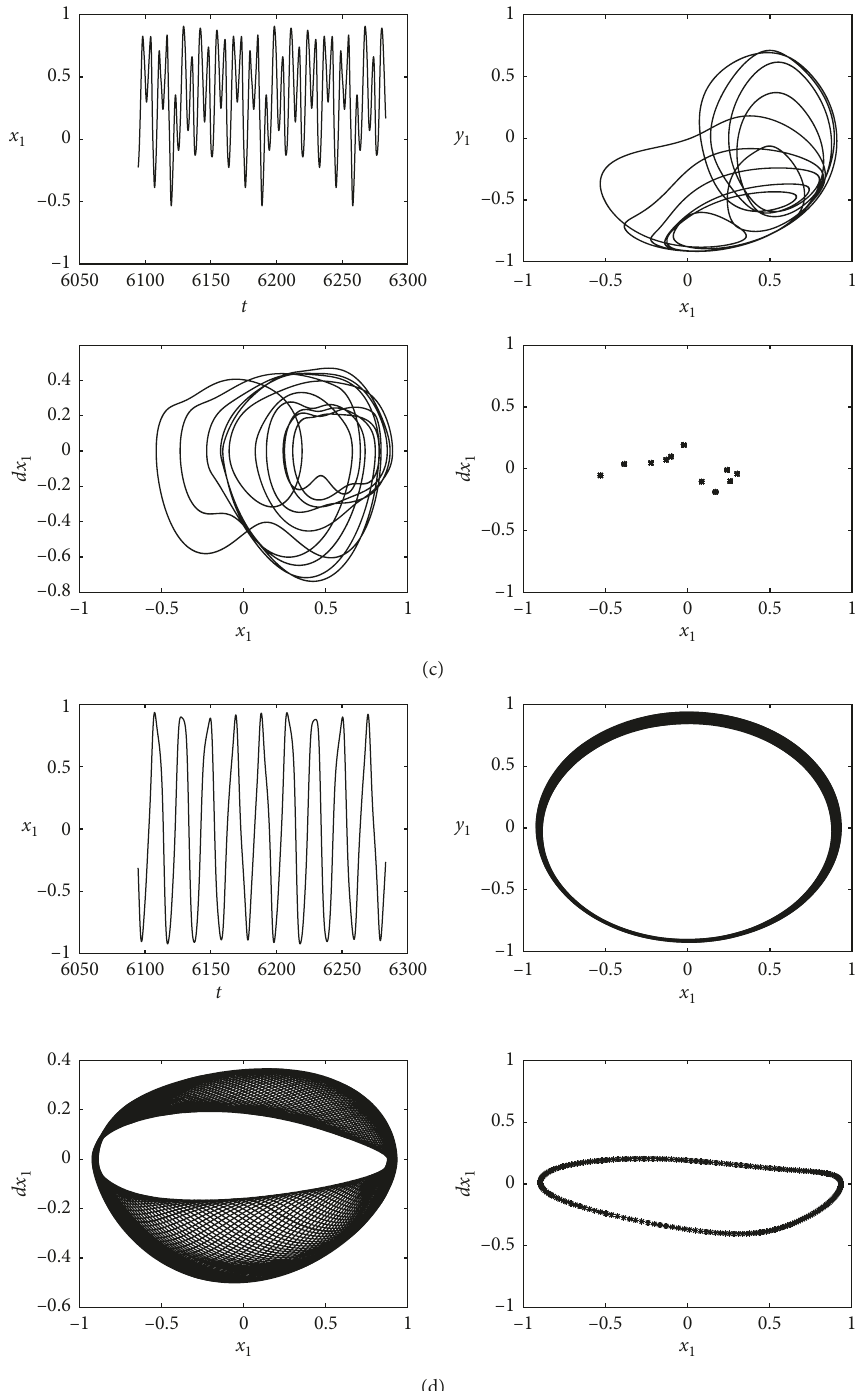
Figure 8: Response of the rotor system at different rotation speeds when b and (d) ω �